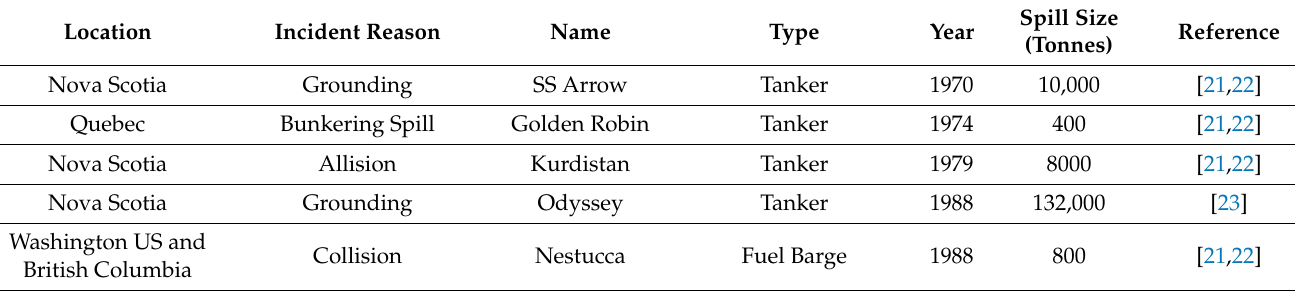
Table 1. Oil Spill Incidents in